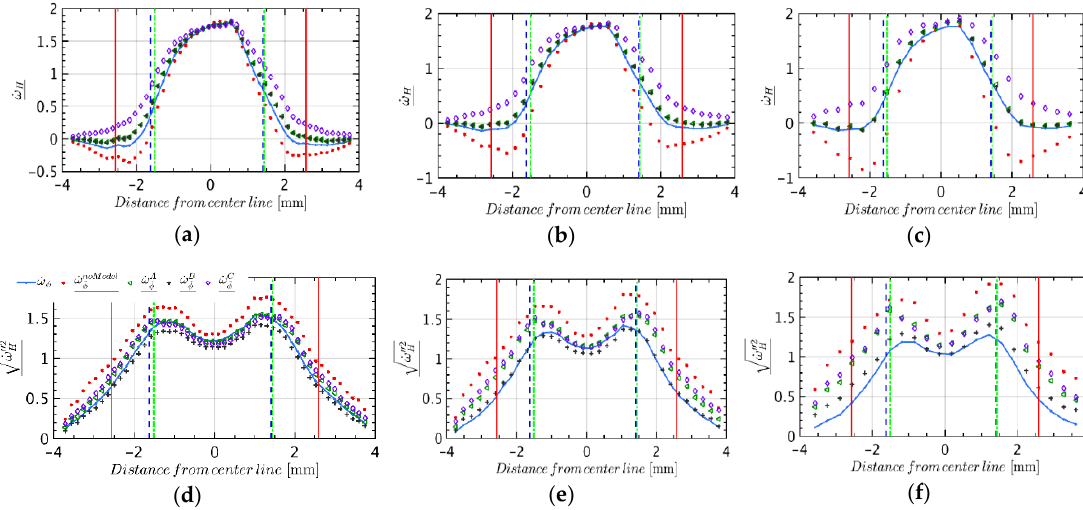
Figure 8. Production/consumption rate of H with units (kg/(m 3 s)): ( a , b , c ) Mean; and ( d , e , f ) RMS. Different filter widths are applied: ( a , d ) ∆/∆ DNS = 8; ( b , e ) ∆/∆ DNS = 12; and ( c , f ) ∆/∆ DNS = 18. The data are extracted at 𝑡 = 35𝑡 𝑗 . Vertical lines are the same as in Figure 3.